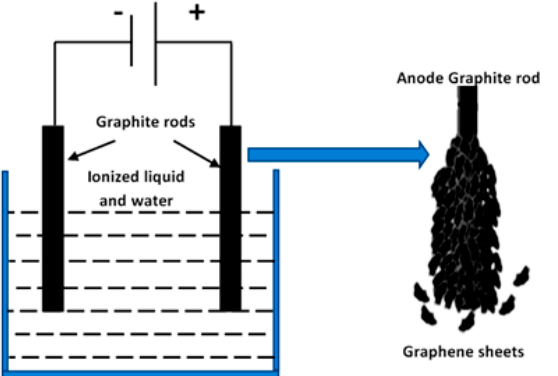
Figure 1. Schematic presentation of the electrochemical cell for producing graphene sheets through the exfoliation process of the graphite anode.